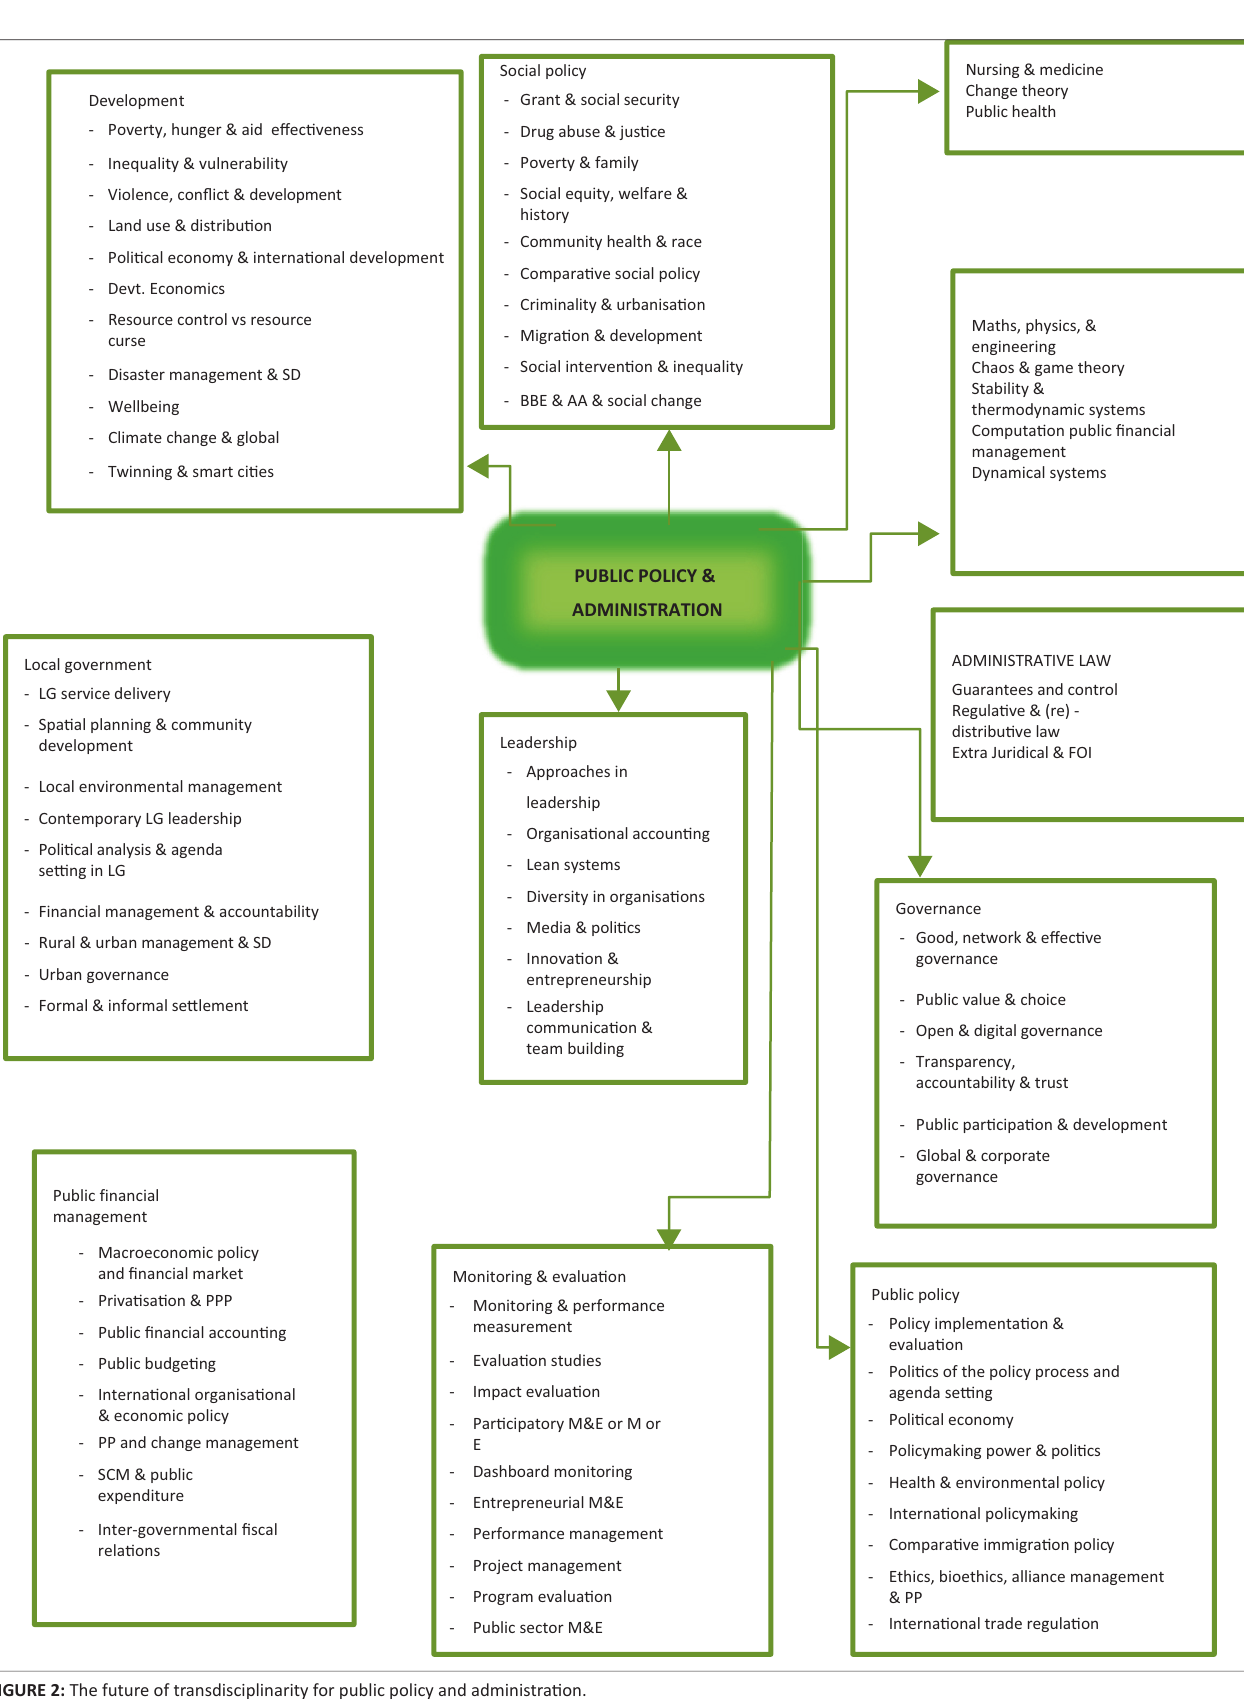
FIGURE 2: The future of transdisciplinarity for public policy and